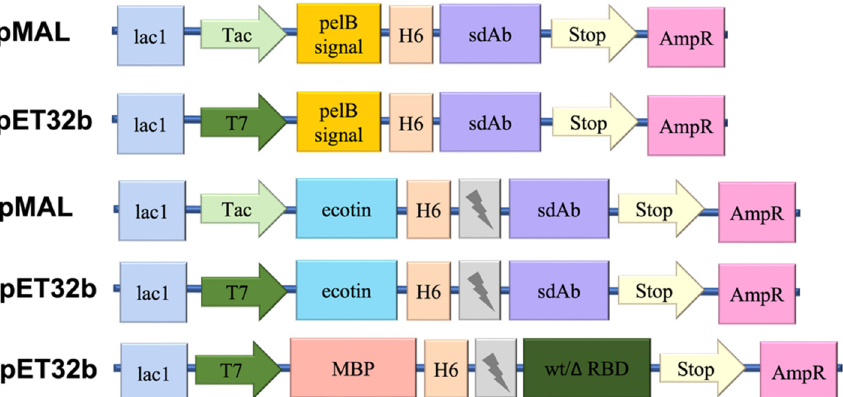
Figure 1. The construction scheme of the pMAL and pET32b vectors containing promoter regions with pelB, ompA, or without a signal sequence and with the ecotin fusion protein, histidine tag, thrombin cleavage site (lightning bolt symbol), and different single domain antibody (sdAb) sequences. The bottom scheme is another pET32b vector containing an MBP fusion protein instead of the ecotin version and containing the wild-type or delta variant of the SARS-CoV-2 spike protein RBD sequences.